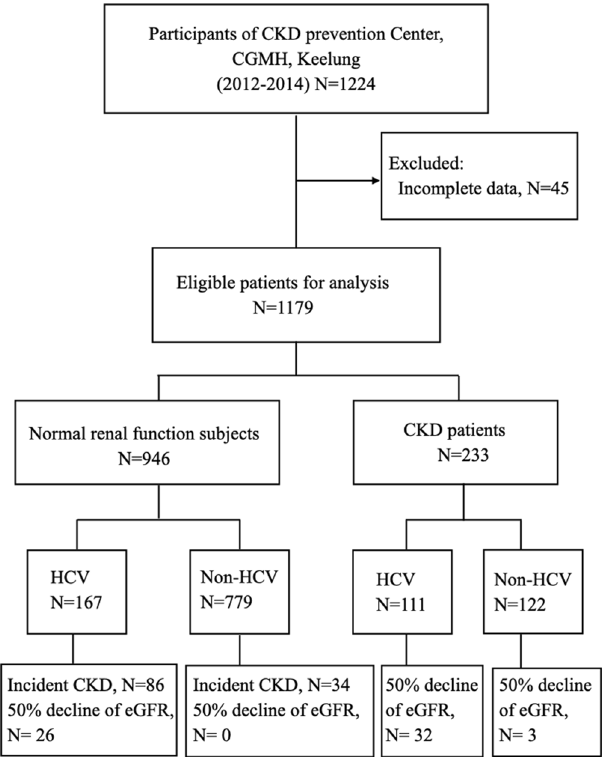
Figure 1. Study design and patient flow schema. CKD, chronic kidney disease; eGFR, estimated glomerular filtration rate; HCV, hepatitis C virus infection.